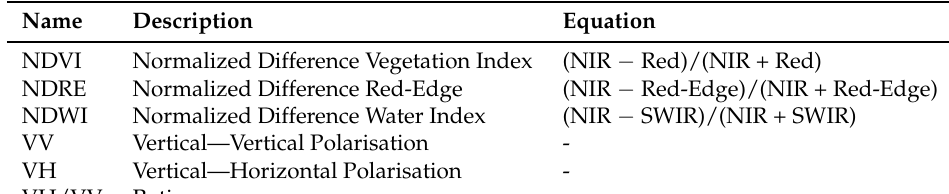
Table 3. Optical and radar features.